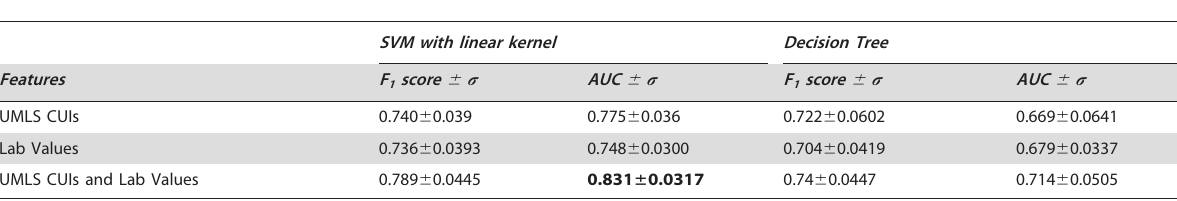
Table 3. Feature contribution.